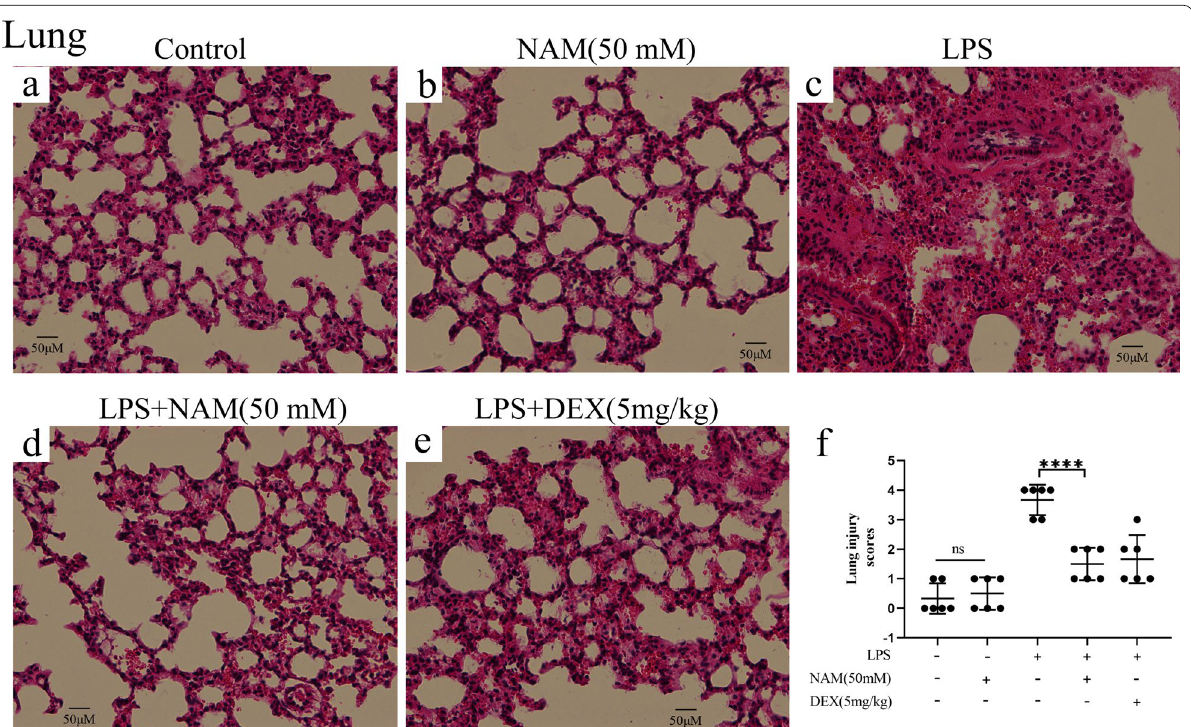
Fig. 2 The results of H&E staining and tissue score of lung injury. Control means no treatment, NAM means NAM treatment, LPS means LPS treatment, LPS NAM means NAM LPS treatment, DEX means NAM + + LPS NAM and LPS DEX groups. f Histological score of lung in each group. The values are presented as the mean + + *** p < 0.001 and **** p <